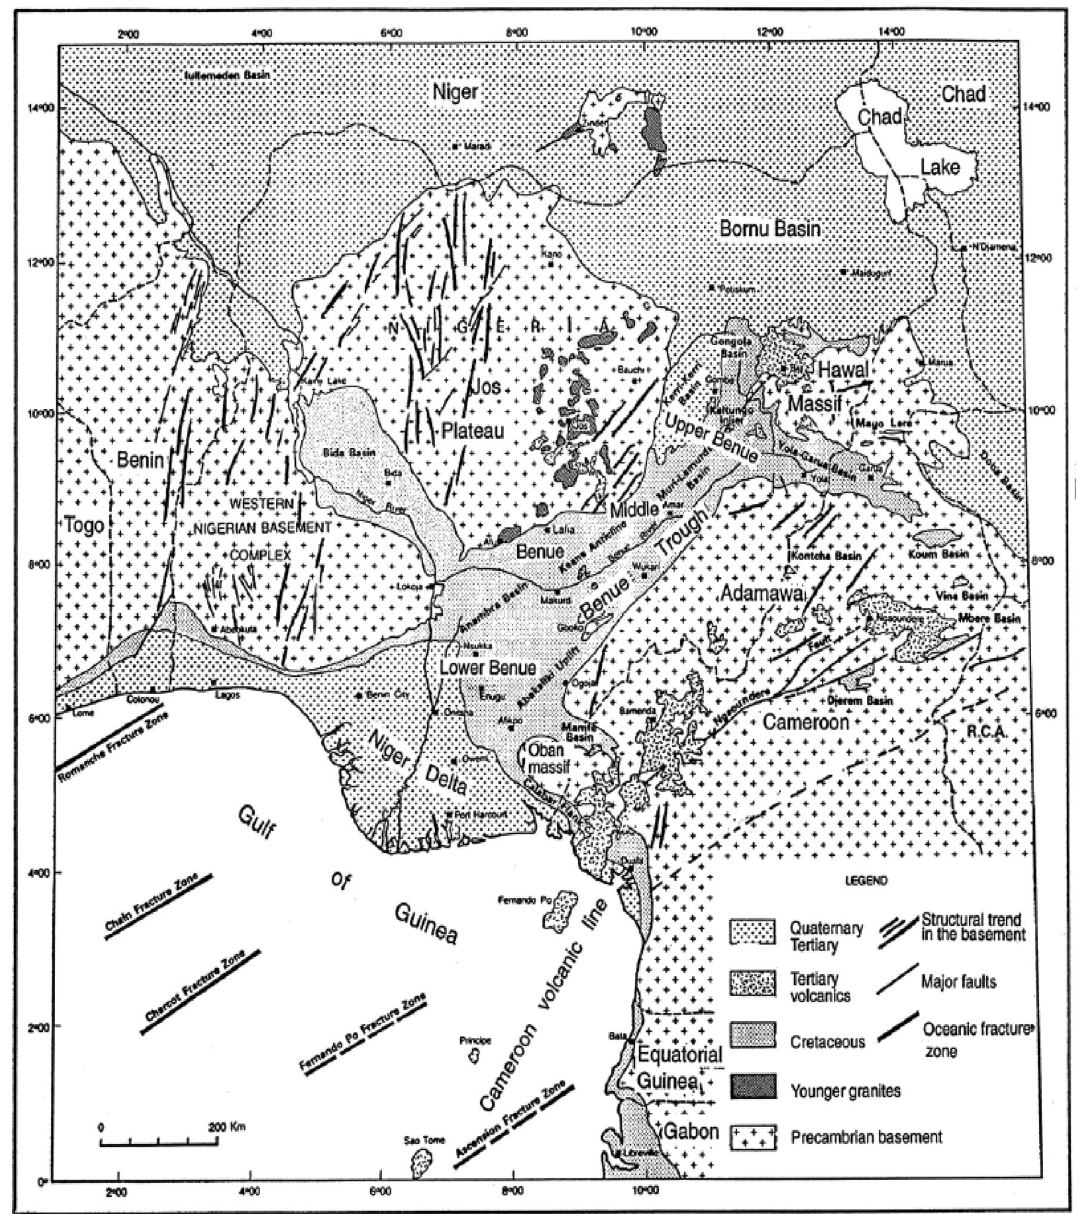
Fig. 2 Geological map of the Benue Trough. The traces of the equatorial fracture zones are indicated. After Odebode